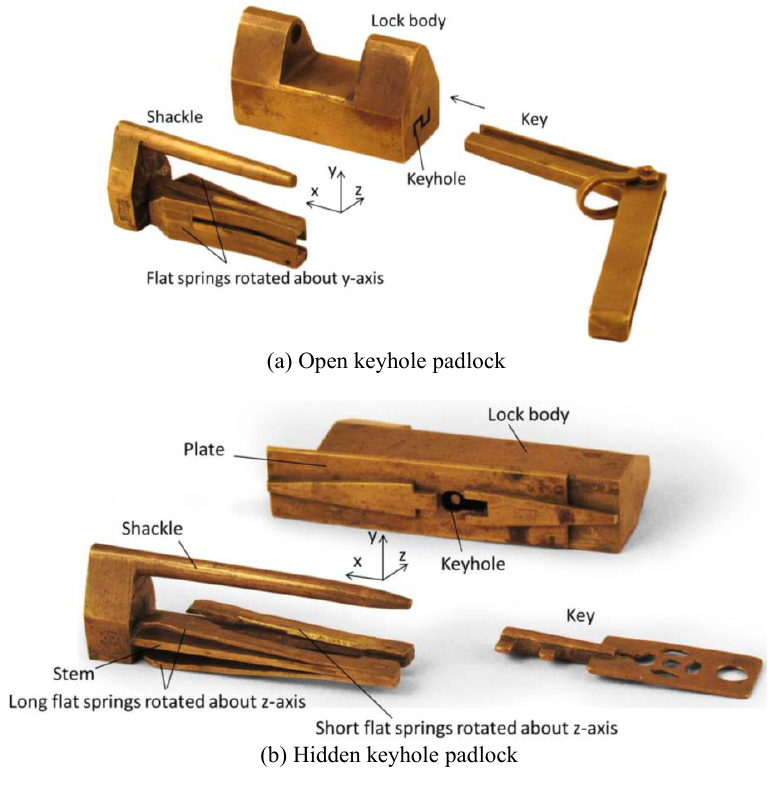
Figure 1. Flat-springs